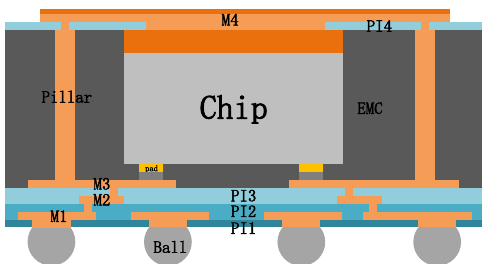
Figure 1. Cross-section of the FOWLP structure. Reprinted with permission from [34]. 2022,